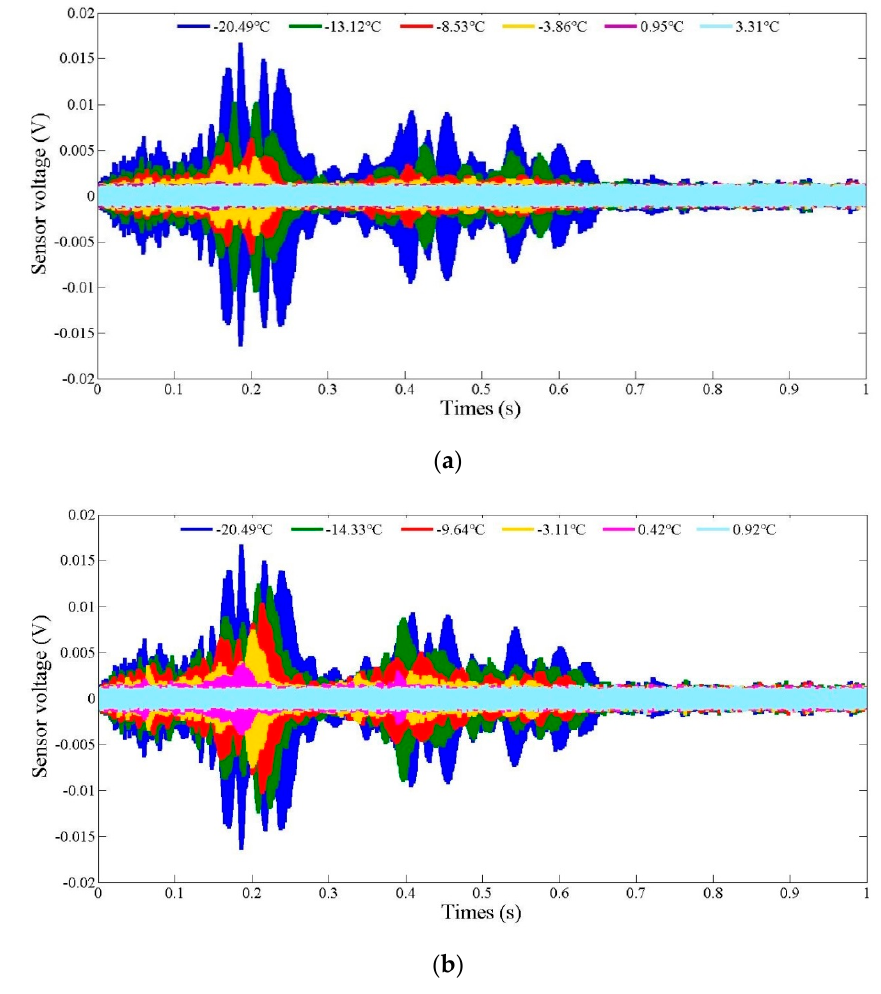
Figure 9. Variation of SA3 signals: ( a ) Freezing process; ( b ) Thawing process.